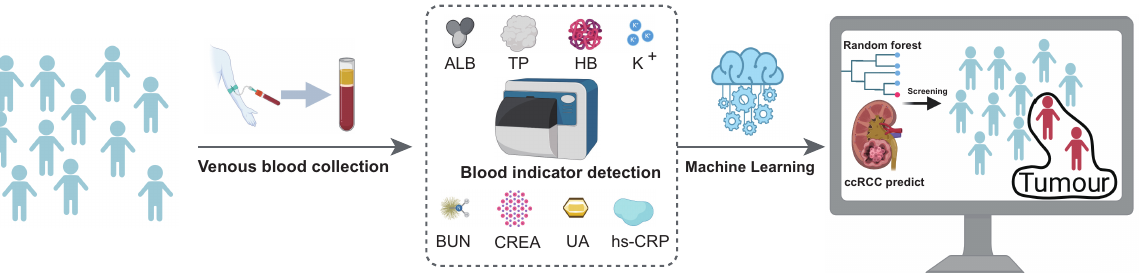
Figure 1. The scheme of early screening for kidney cancer and research protocol. We collected data from healthy people and patients diagnosed with ccRCC. The blood samples were measured by biochem- ical instruments for eight main indicators: ALB, TP, HB, K + , BUN, CREA, UA and hs-CRP. After the data were measured, the indicators were introduced into the RF model for training. Finally, the prediction model’s performance was tested to achieve accurate classification and prediction